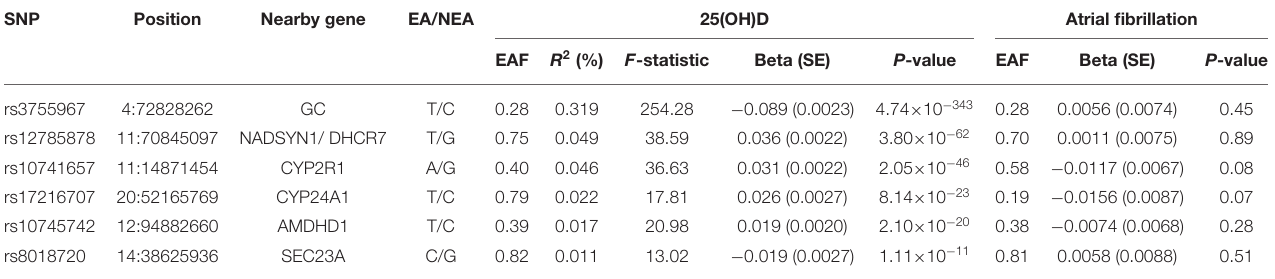
TABLE 1 | Characteristics of the 25(OH)D-associated SNPs. SNP Position Nearby gene EA/NEA